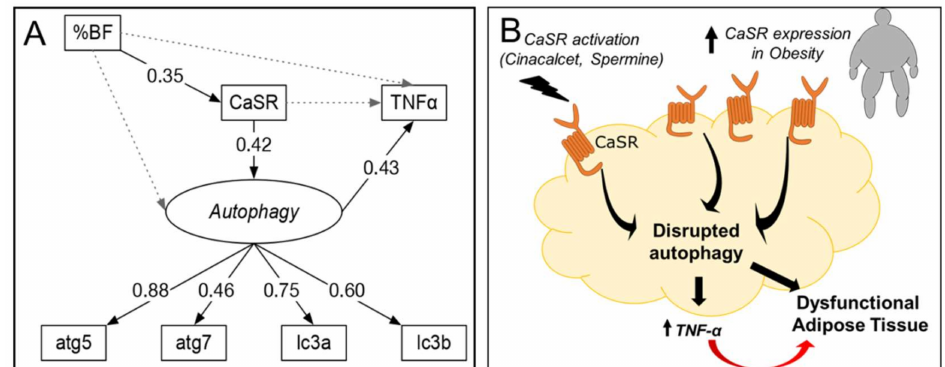
Figure 6. Standardized solution for SEM analysis and proposed model. ( A ) Solid and dashed arrows indicate the evaluated significant ( p < 0.05) and non-significant associations, respectively. Numbers indicate significant standardized e ff ects (from − 1 to 1). Labels in italics represent latent variables (see methods section). %BF: body fat percentage. Variances for each variable can be found in Supplementary Materials (Table S5). ( B ) Proposed schematic model based on our